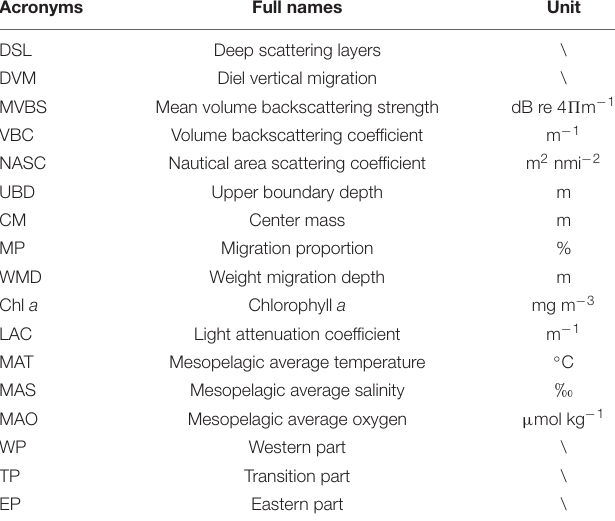
TABLE 1 | List of